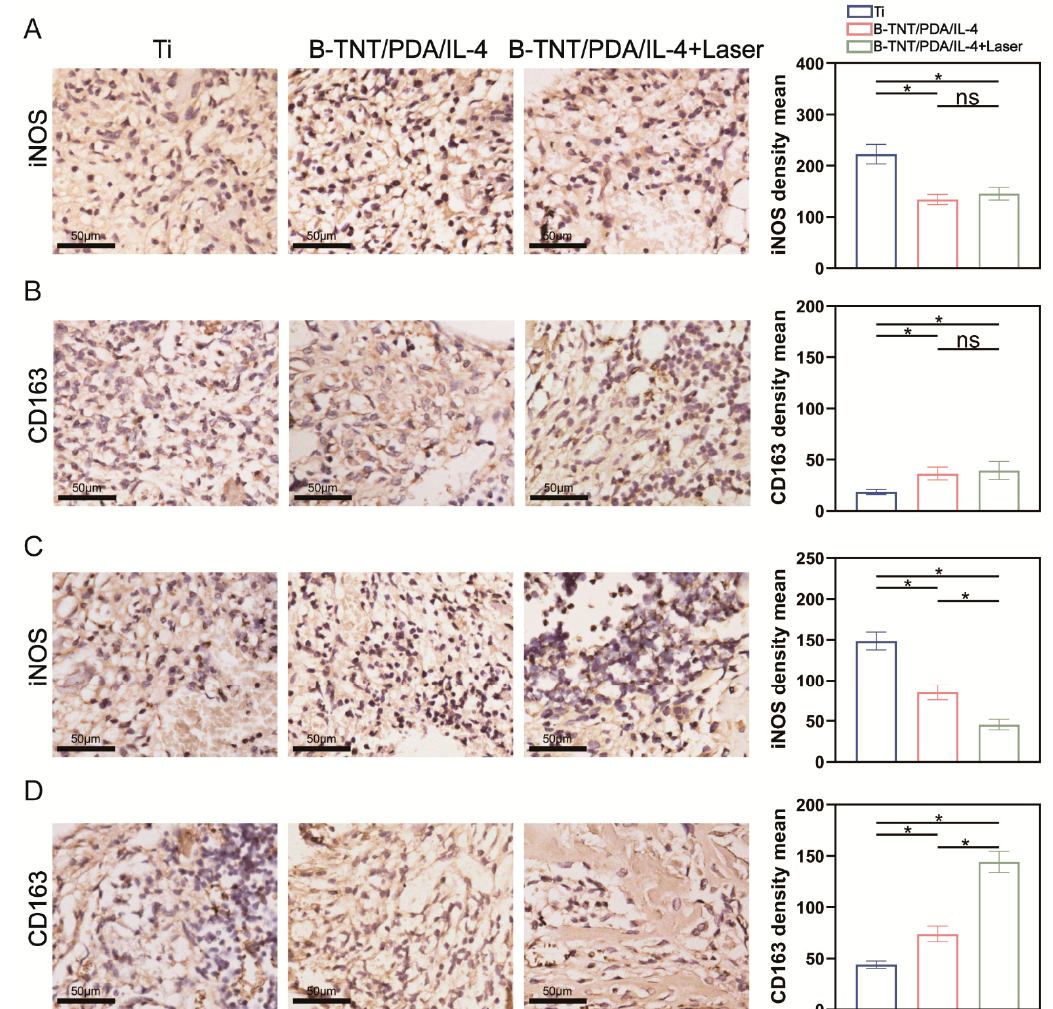
Figure 8. ( A ) Inducible nitric oxide synthase (iNOS) staining images and quantitative assessment of iNOS + cells after 3 days of implantation. ( B ) CD163 staining images and quantitative assessment of CD163 + cells after 3 days of implantation. ( C ) iNOS staining images and quantitative assessment of iNOS + cells after 7 days of implantation. ( D ) CD163 staining images and quantitative assessment of CD163 + cells after 7 days of implantation. * indicates statistical difference between groups ( p < 0.05); ns means no statistical difference between groups. Figure 9A demonstrates the reconstructed 3D images 4 weeks after implantation, with gray and purple colors representing implant and new bone formation, respectively.